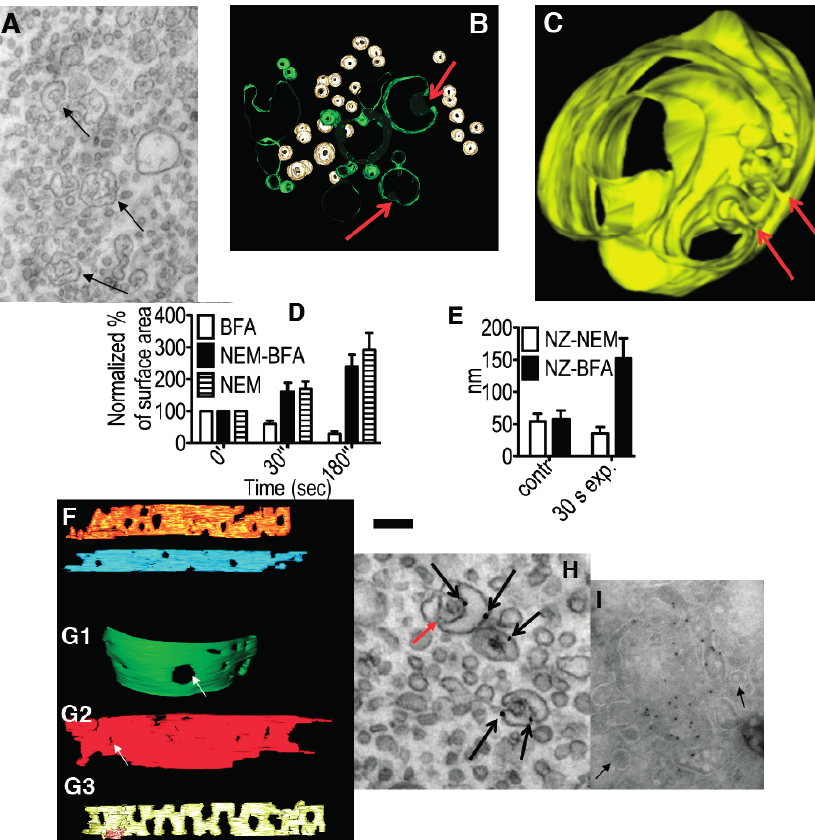
Figure 2. Effects of inhibition of membrane fusion on the Golgi. ( A ) HeLa cells 30 min after microinjection of α SNAPmu. Arrows, cisternal remnants; ( B , C ) Three-dimensional models of cisternal remnants after surface rendering. Arrows, invaginations. Cisternal remnants are green ( B ) and yellow ( C ). Vesicles in ( B ) are white; ( D ) Normalized surface areas of RPs versus Golgi cisternae after treatment with BFA alone (white bars), 30 s after treatment with N -ethylmaleimide (NEM) and then brefeldin A (BFA; black bars), or 30 s after NEM treatment alone (striated bars); ( E ) Mean diameter of cisternal pores determined using EM tomography. Each experiment was compared with its own control; ( F ) Cells were treated with 33 µM nocodazole (NZ) or 5 min, and then additionally incubated 30 s with NZ alone (blue cisterna in F ), NZ + 5 µg/mL BFA (orange cisterna) or NZ + 1 µM NEM (yellow cisterna). ( F , G ) Examples of three-dimensional models of control (blue in F ) penultimate medial cisternae after inhibition of vesiculation (NZ + BFA, orange in F ) or membrane fusion (NZ + NEM, yellow in F ) machineries; ( G ) Isolated Golgi membranes were incubated with 5 mg/mL native cytosol, the ATP restoration system (ARS), GTP: without (G1) or with the mutant of α SNAP ( α SNAPmu; G2) for 20 min. Pores are indicated with white arrows. Addition of α -SNAPmu induced narrowing of cisternal pores; ( H ) HeLa cells treated with NEM and analyzed 3 min after re-warming; mannosidase II (ManII) was labeled by nano-gold (arrows). Red arrow, cisternal invagination; ( I ) Incubation of isolated Golgi membranes with native cytosol, ARS/GTP ( G ) and α SNAPmu for 90 min. Cryosection labeled for ManII. Vesicles (arrows) do not contain ManII. Bars. 300 nm ( A ); 100 nm ( B ); 50 nm ( C ); 250 nm ( F , G ); 120 nm ( H , I